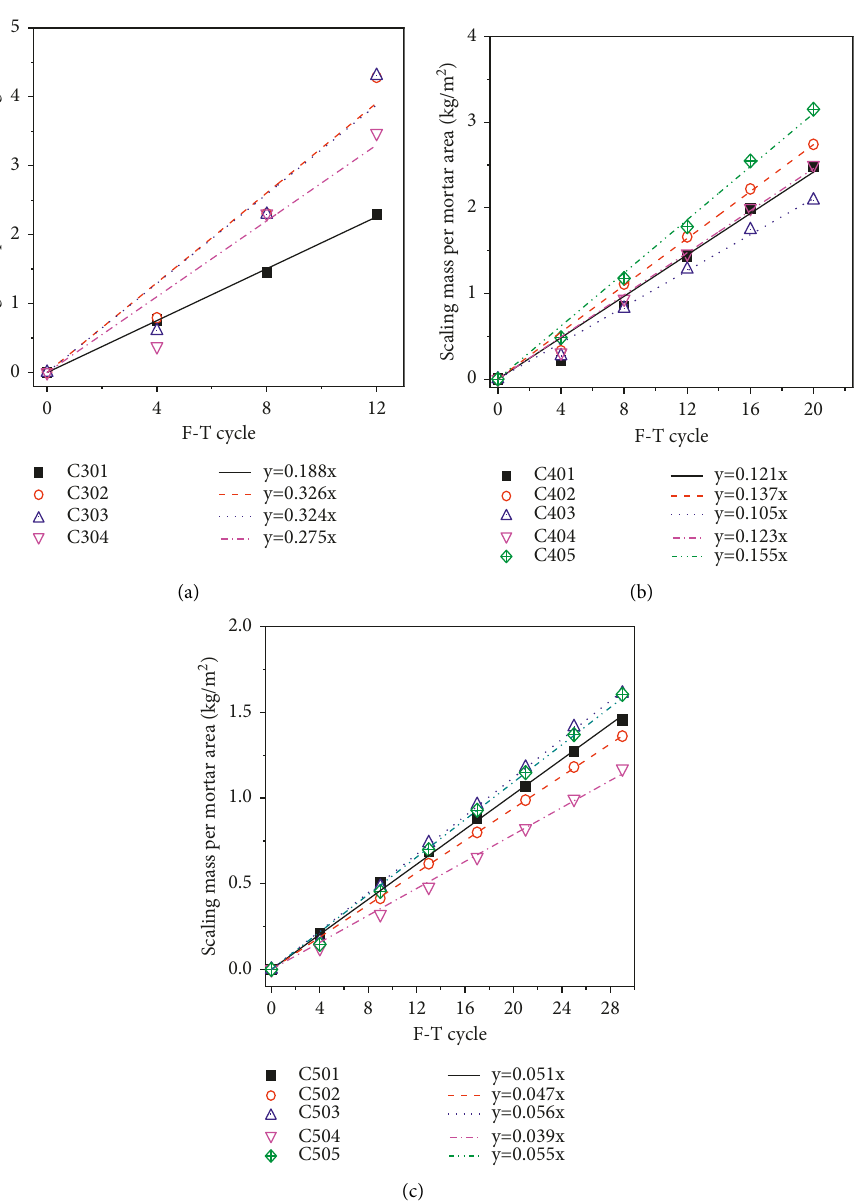
Figure 5: Scaling mass per mortar area at 28d curing